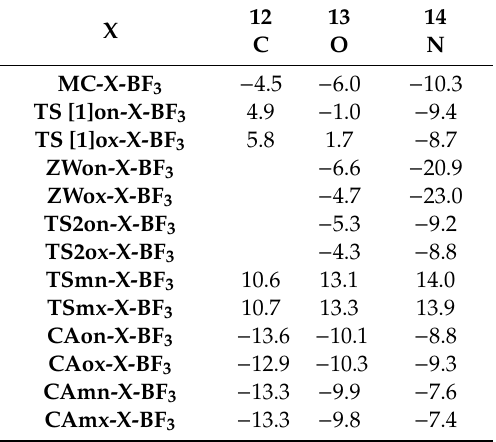
Table 4. B3LYP / 6-311G(d,p) gas phase relative energies, with respect to separate reagent in kcal · mol − 1 , of the stationary points involved in the P-DA reactions of Cps 12 – 14 with complex 7-BF 3 .